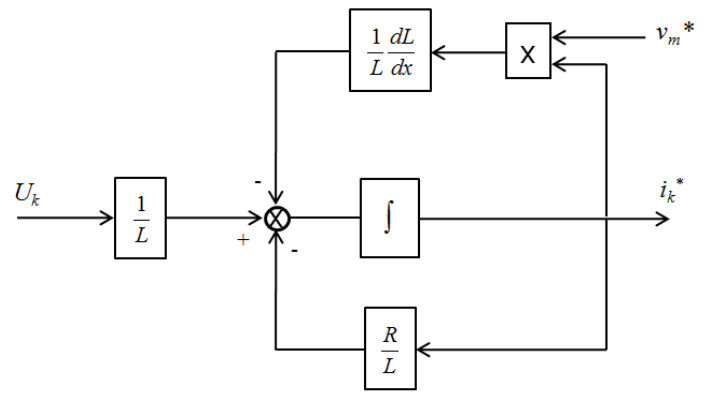
Figure 9. Electrical modeling of one phase of the